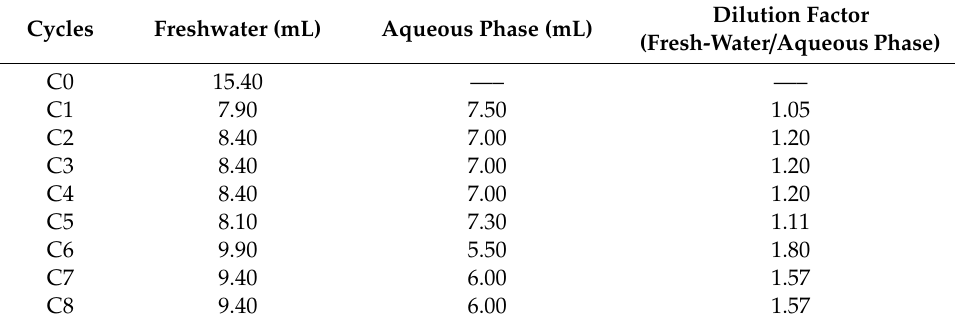
Table 3. Amount of aqueous phase and water added in the SS at each cycle.